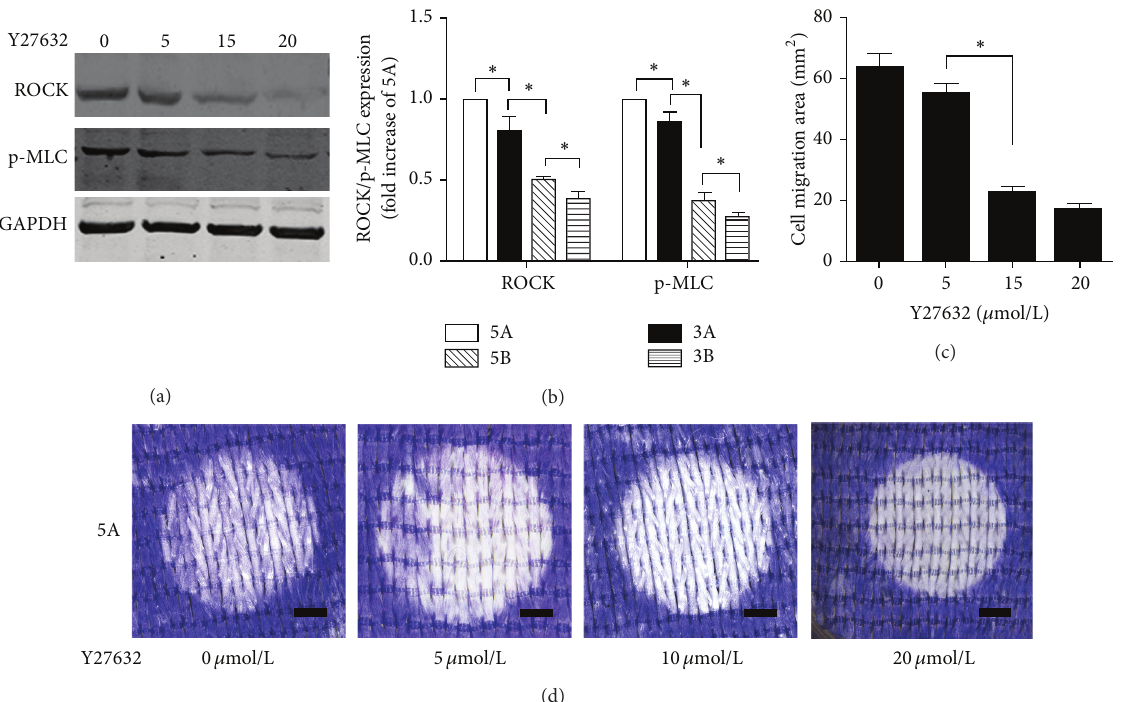
Figure 4: Western blot (a) and semiquantitative analysis (b) of ROCK and p-MLC expression in BMSCs on 5A PET-ALs after incubation for 72 h in the concentration gradient of 0, 5, 10, and 20 𝜇 mol/L of Y27632. Stereomicroscope images (d) of Giemsa staining of 5A PE-ALs treated with different concentrations of Y27632 and histogram of cell migration area (c) which was analyzed from the stereomicroscope images. ∗ indicates 𝑝 < 0.05 . Scale bars: